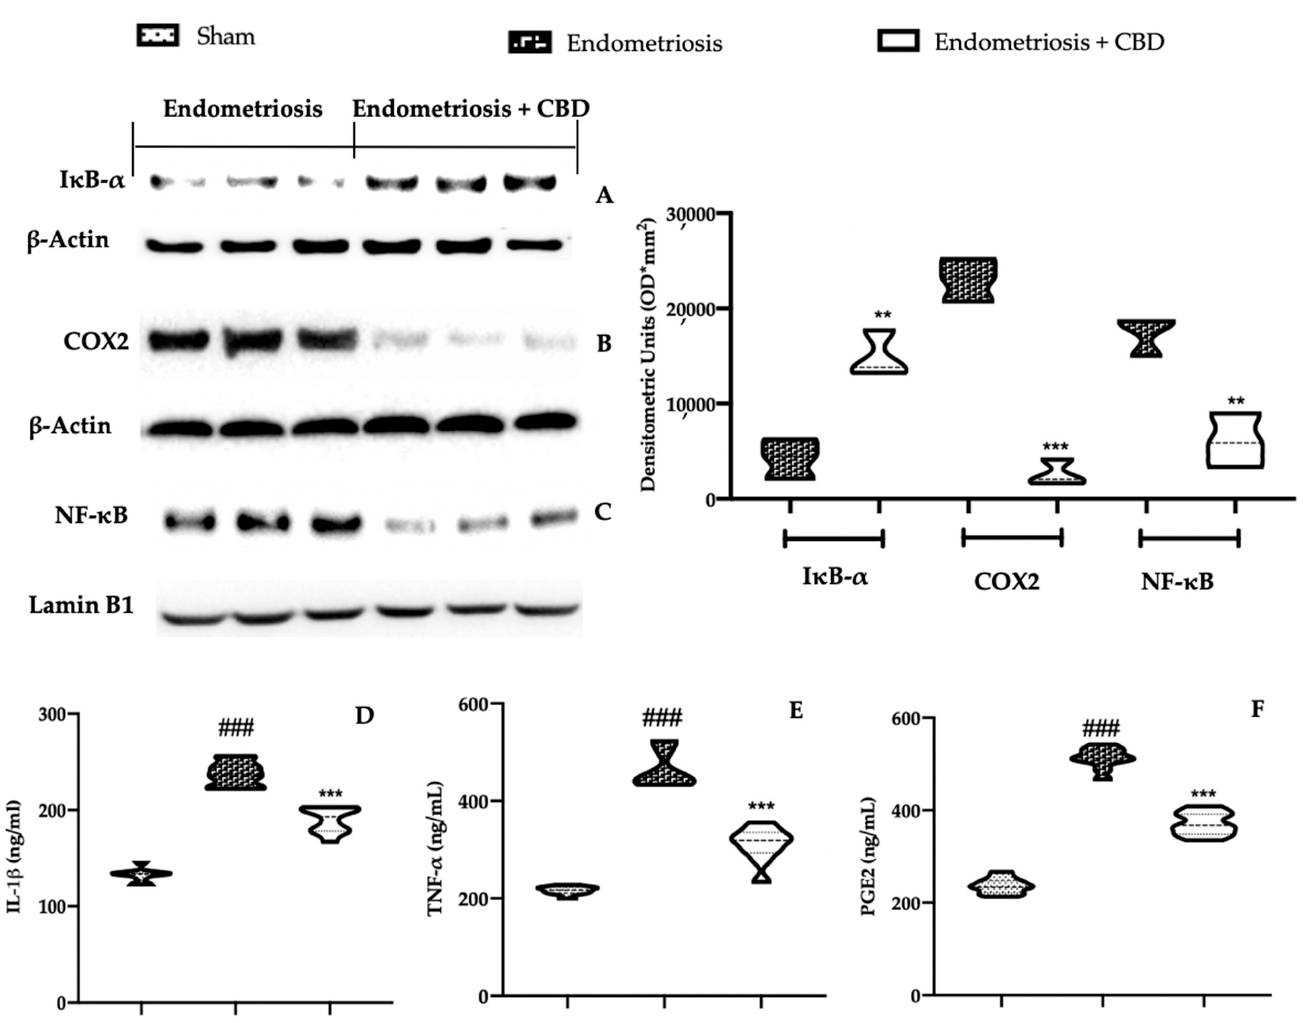
Figure 4. CBD administration reduced the pro-inflammatory state endometriosis-induced: Western blot analysis of Ikb- α ( A ), COX2 ( B ), NF-kB ( C ), IL-1 β ( D ), TNF- α ( E ) and PGE 2 ( F ) levels in the peritoneal fluids. For each analysis, n = 5 animals were employed. ** p < 0.01 vs. endometriosis, *** p < 0.001 vs. endometriosis, ### p < 0.001 vs. sham.